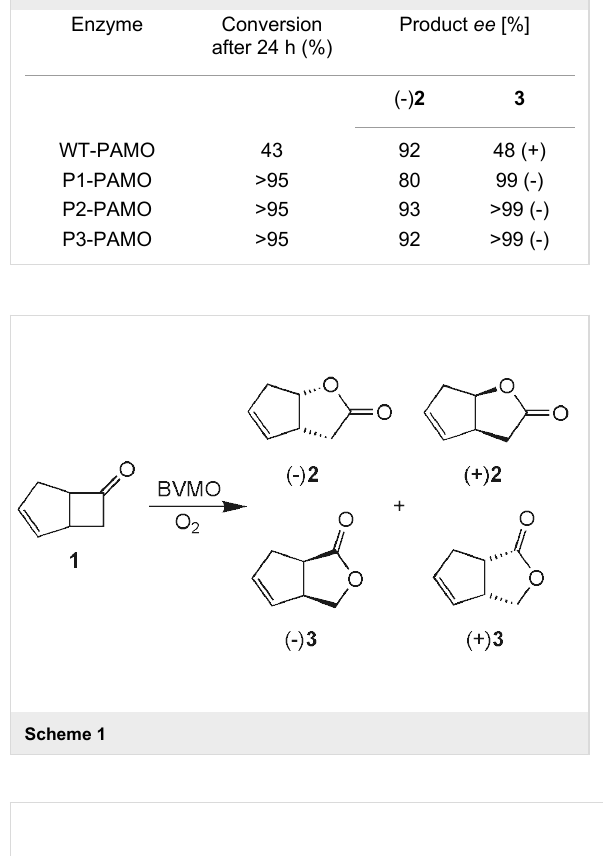
Table 1: Activity of PAMO and PAMO-mutants in the BV-oxidation of bicyclo[3.2.0]hept-2-en-6-one ( 1 ) at a substrate concentration of 1 g/L in whole-cell